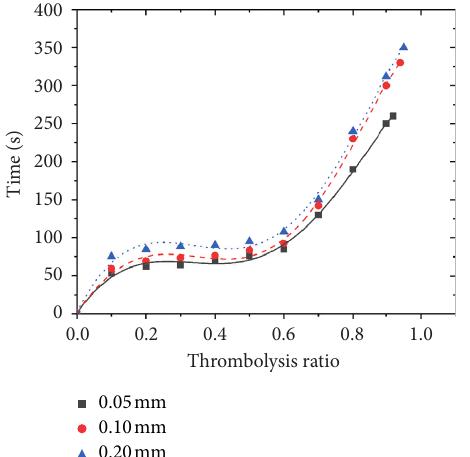
Figure 9: Thrombolysis time for different positions of 0.05mm, 0.10mm, and 0.20mm. Thrombolysis ratio of 1.0 denotes complete dissolution.